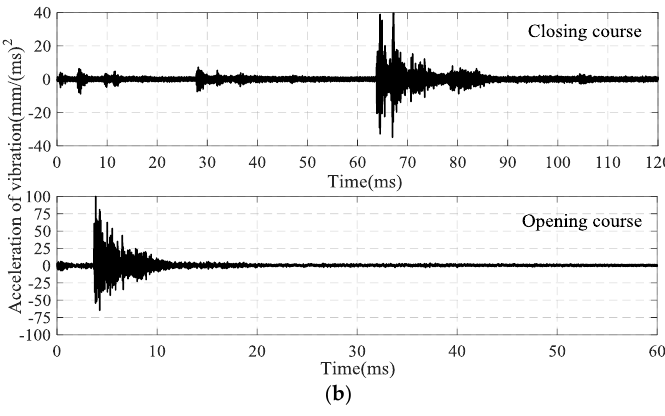
Figure 2. ( a ) Acquisition system with HVCB; ( b ) The measured vibration signal at normal condition.